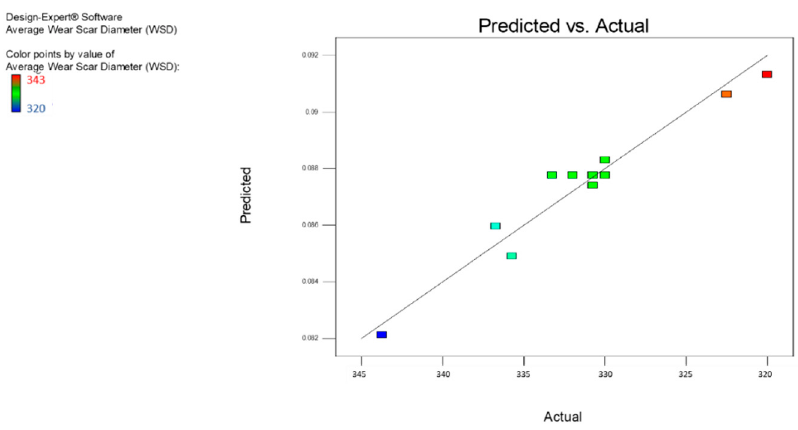
Figure 12. The residuals vs. the experimental run of the average WSD for the MoS 2 nanolubricants.